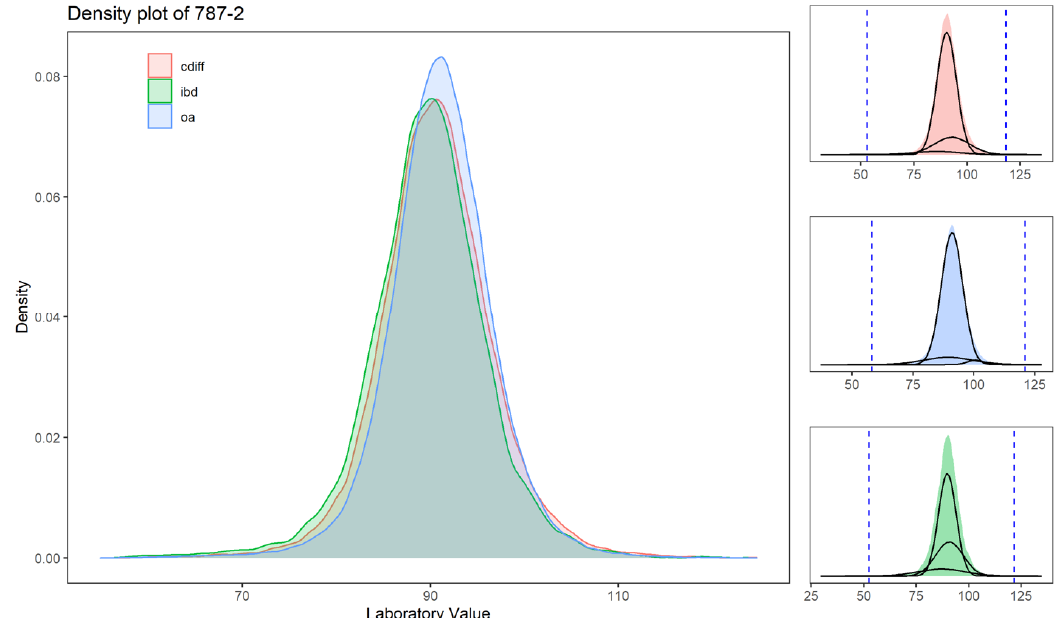
Figure 3. Distribution of laboratory values normalized for LOINC 787-2 (mean corpuscular volume or MCV) for the three datasets (Cdiff in red, IBD in green, and OA in blue). The “MCV” is missing at 2% in the Cdiff dataset, 5% in the IBD dataset, and 4% in the OA dataset. The subpanels represent the three modeled distributions to calculate the upper and lower boundaries. The dashed lines represent the upper and lower outlier boundaries (based on Equation (1)).